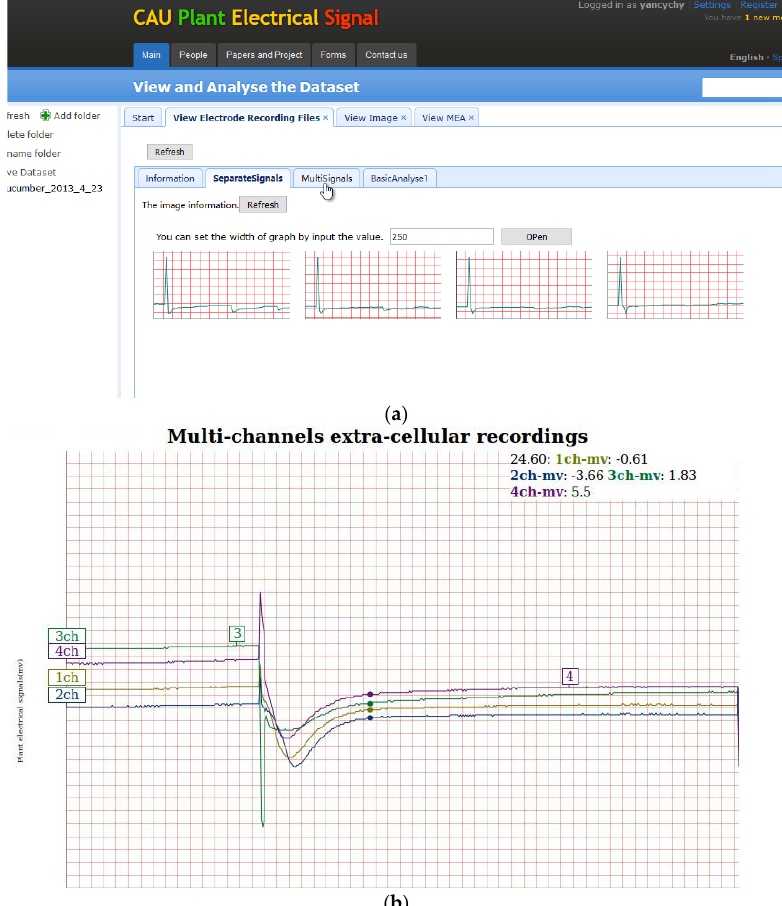
Figure 10. Visualization of multi-channel plant electrical signals ( a ) in separated views ( b ) in the same view.